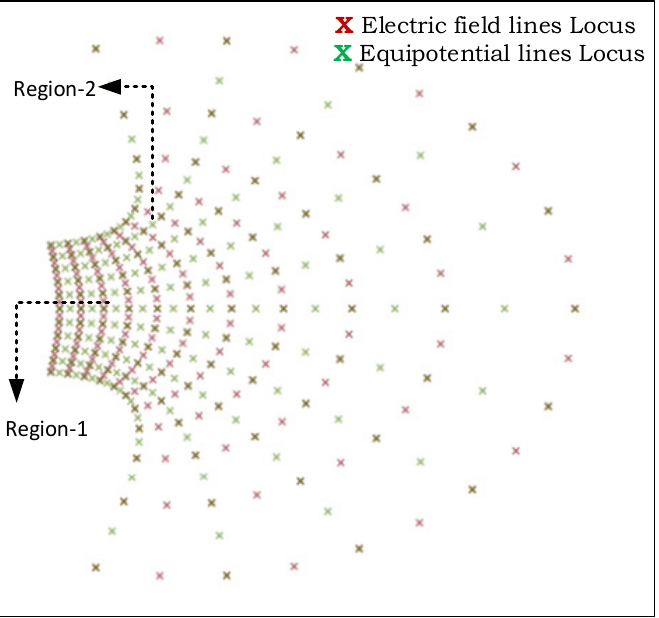
Figure 4. Conformal mapping of Rogowski profile for A = π .